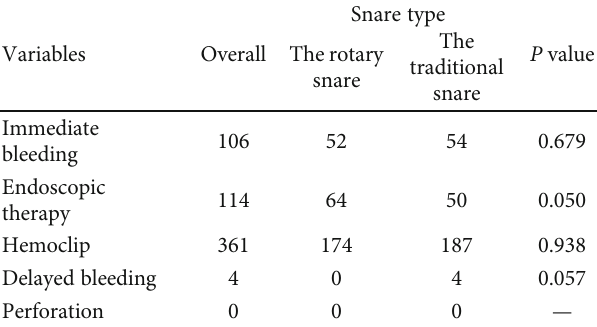
Figure 3: Comparison of polypectomy procedure times in size, morphology, site, and access (SMSA) score between the traditional snare group and rotary snare group. Table 3: Adverse events per